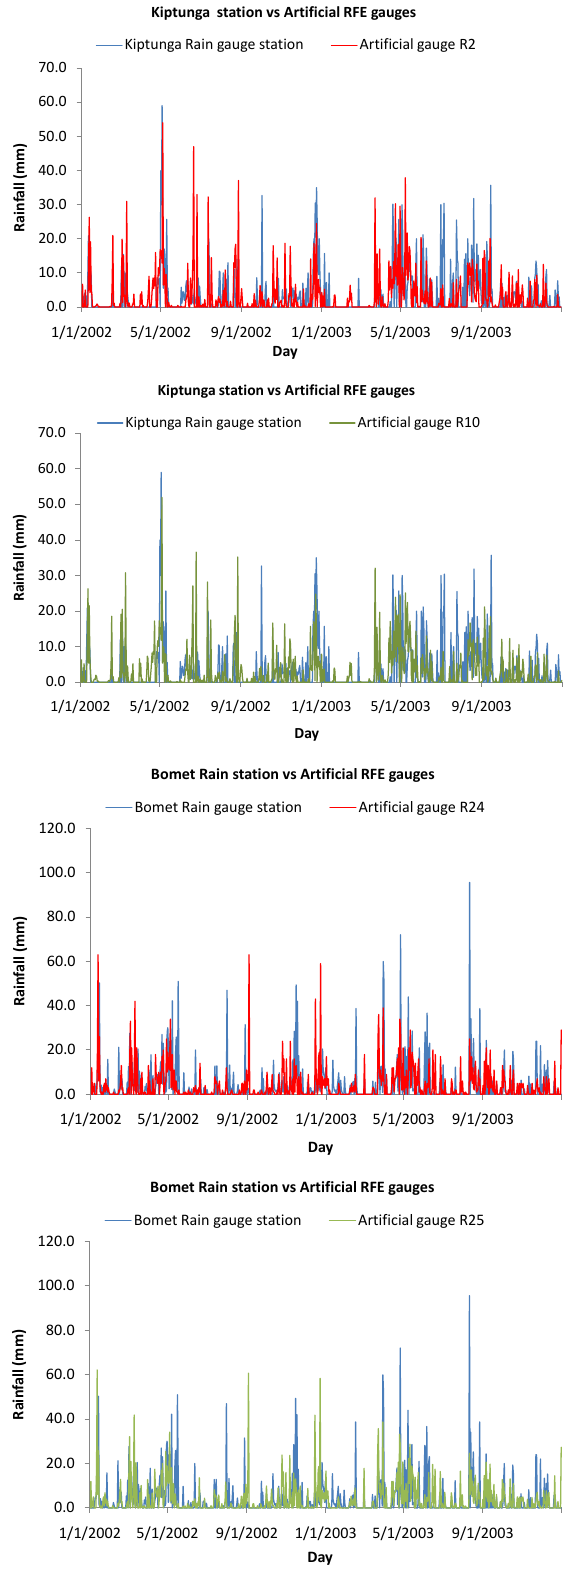
Fig. 4. Comparison between the daily rain gauge and artificial RFE gauge data.